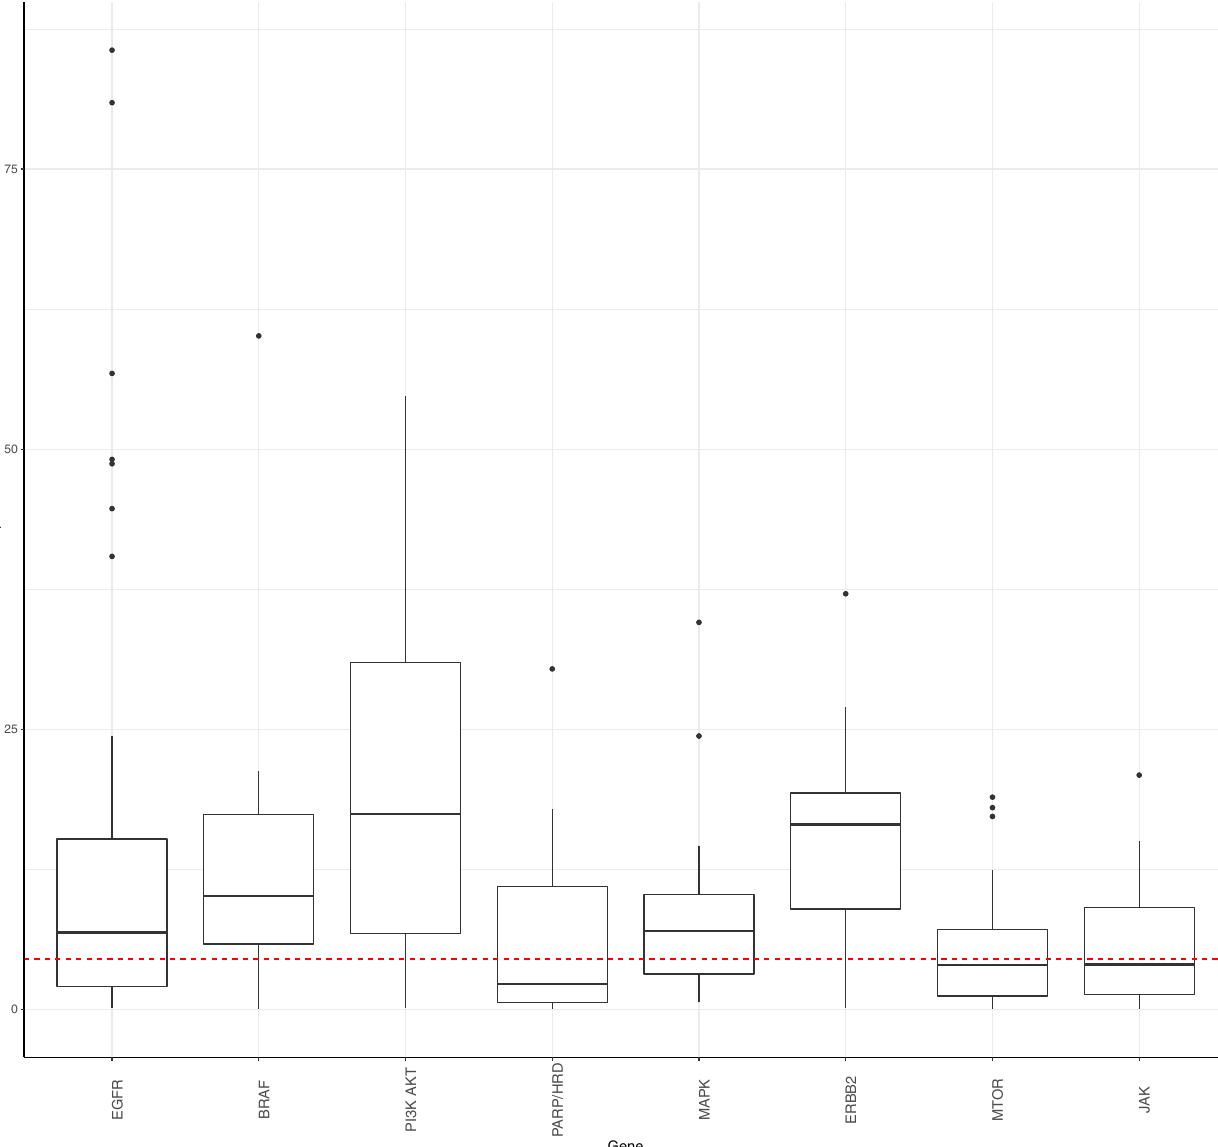
Fig. 2 Phenocopy signatures signi fi cantly add to DNA mutations in predicting drug response across oncogenic pathways. Linear models for drug response were used to assess how much the phenocopy signatures added to DNA mutations across pathways. Each data point used in the boxplot represents a model for a single drug in a dataset. A larger χ 2 value represents a more signi fi cant contribution of the phenocopy signature to DNA mutations. Red dotted line represents a signi fi cant FDR threshold of 0.05. Boxplots show median values along with the interquartile